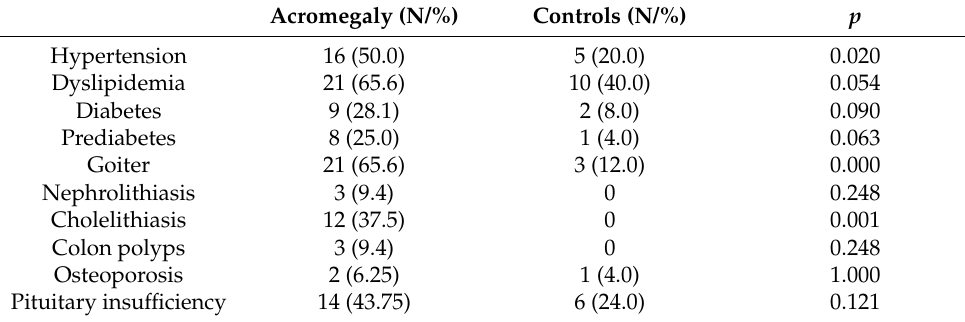
Table 3. Comorbidities in acromegaly and the